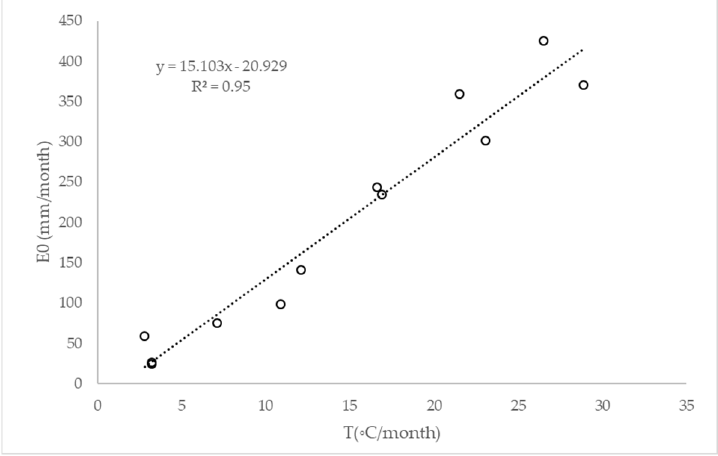
Figure A2. R2 between monthly evapotranspiration (E 0 ) and average temperature (T) for the Polchehr reference station in 1995.